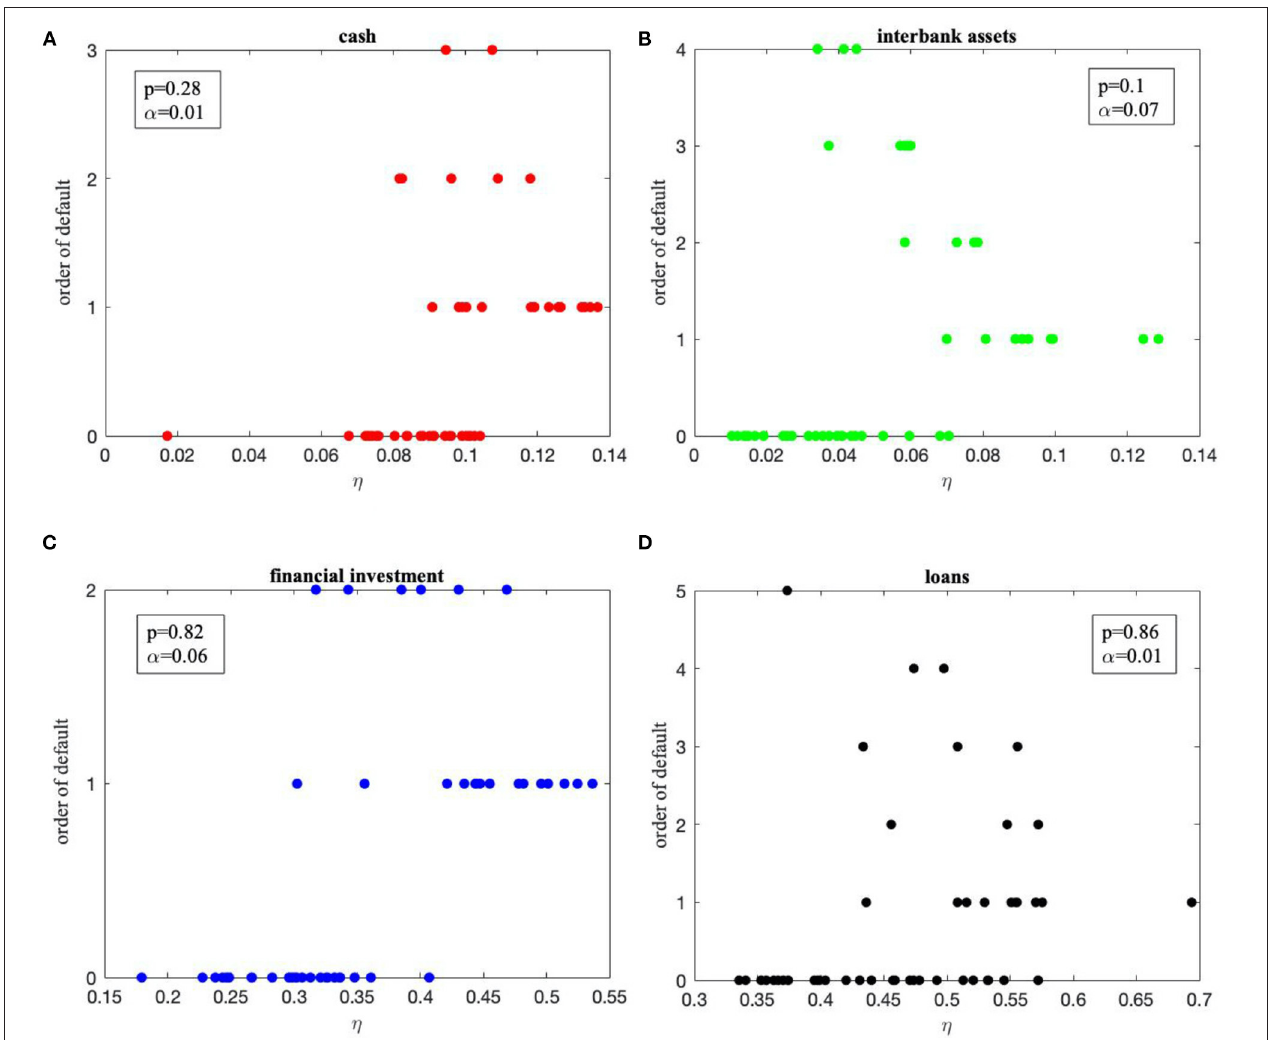
FIGURE 5 | (A–D) The order of default under different values of η when cash assets, interbank assets, financial investment assets, loan assets, and other types of assets are shocked, respectively. The default order is 0 meaning the bank